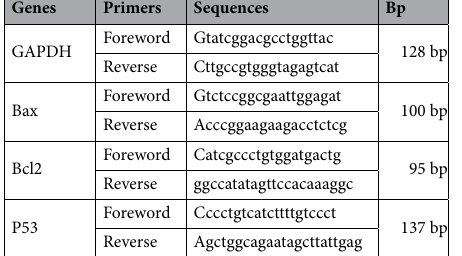
Table 1. Primers sequences used in quantitative real time PCR